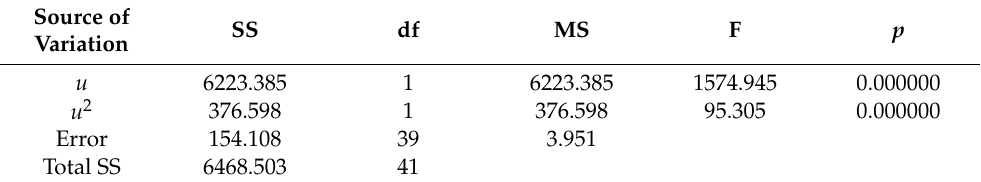
Figure 19. Response surface plot for the impact strength versus wheat bran content u and screw speed n. 3.3.3. Tensile Strength The determined relation describing the variation of tensile strength was presented by means of a polynomial (Equation (11)):  = 37.94986 − 0.55714𝑢 + 0.00144𝑢 (cid:2870) (11) The initial analysis of the full model (Figure 20) indicated that the effect of both the wheat bran content u and the screw speed n was significant. However, the applied backward stepwise regression method of model building eventually demonstrated that,